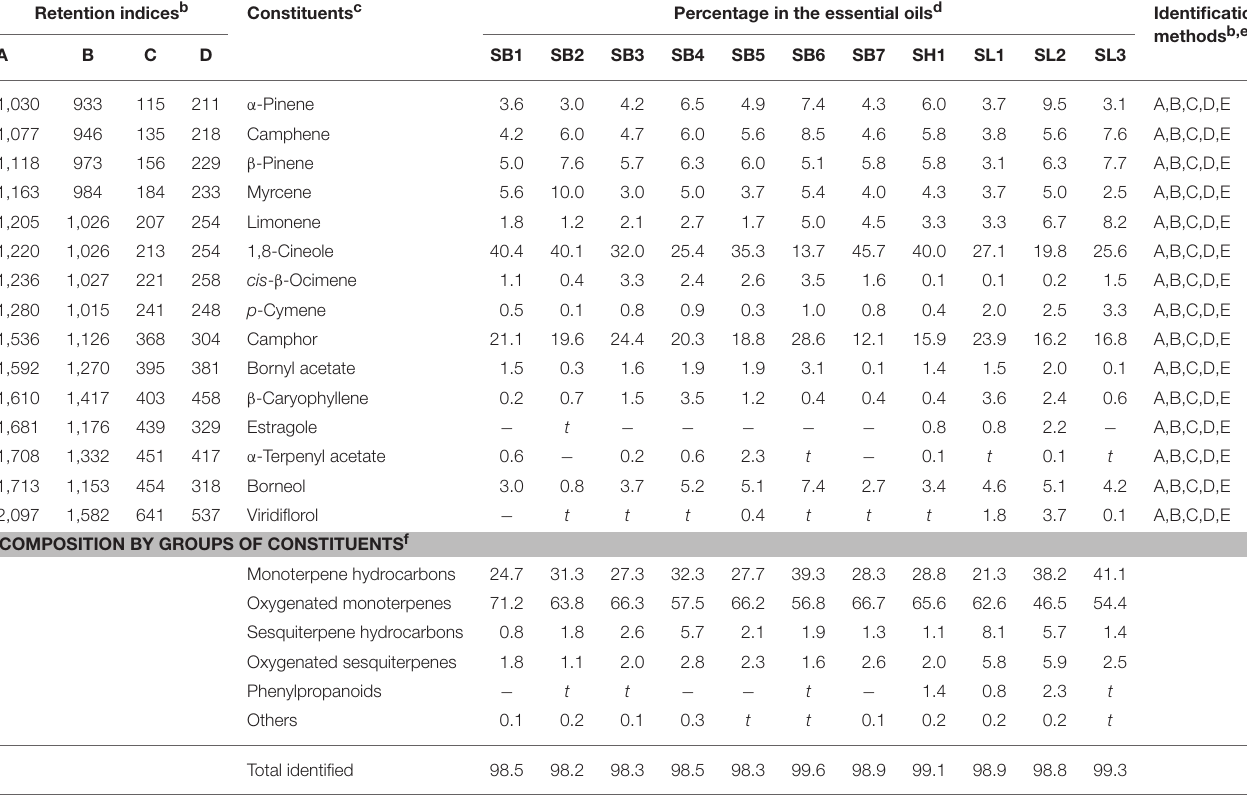
TABLE 4 | Composition of the essential oils of Salvia blancoana subsp. mariolensis , S. x hegelmaieri and S. officinalis subsp. lavandulifolia from the Valencia region (Spain) and close areas a . Retention indices b Constituents c Percentage in the essential oils